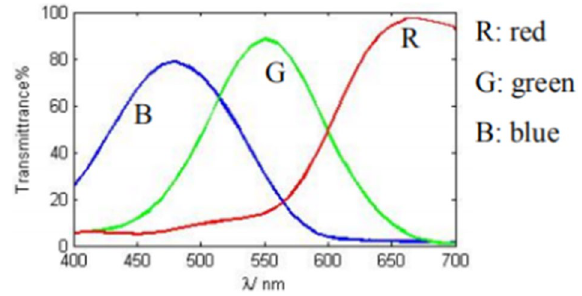
Figure 2. Spectral coupling curve of